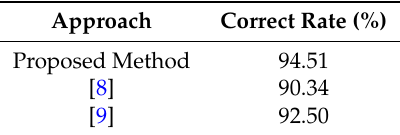
Table 6. Correct Rate (%) comparison of proposed method with previous work of gender